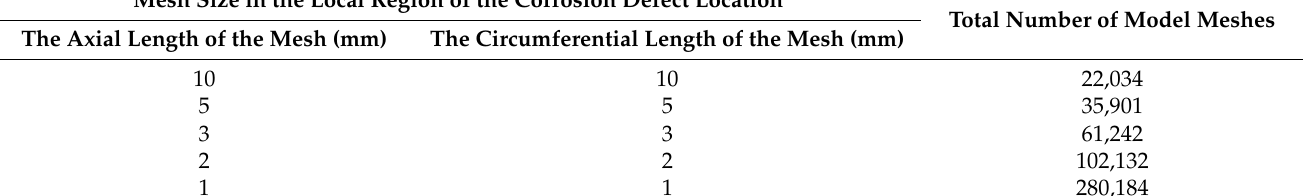
Table 3. Different mesh sizes and amounts for mesh sensitivity analysis.